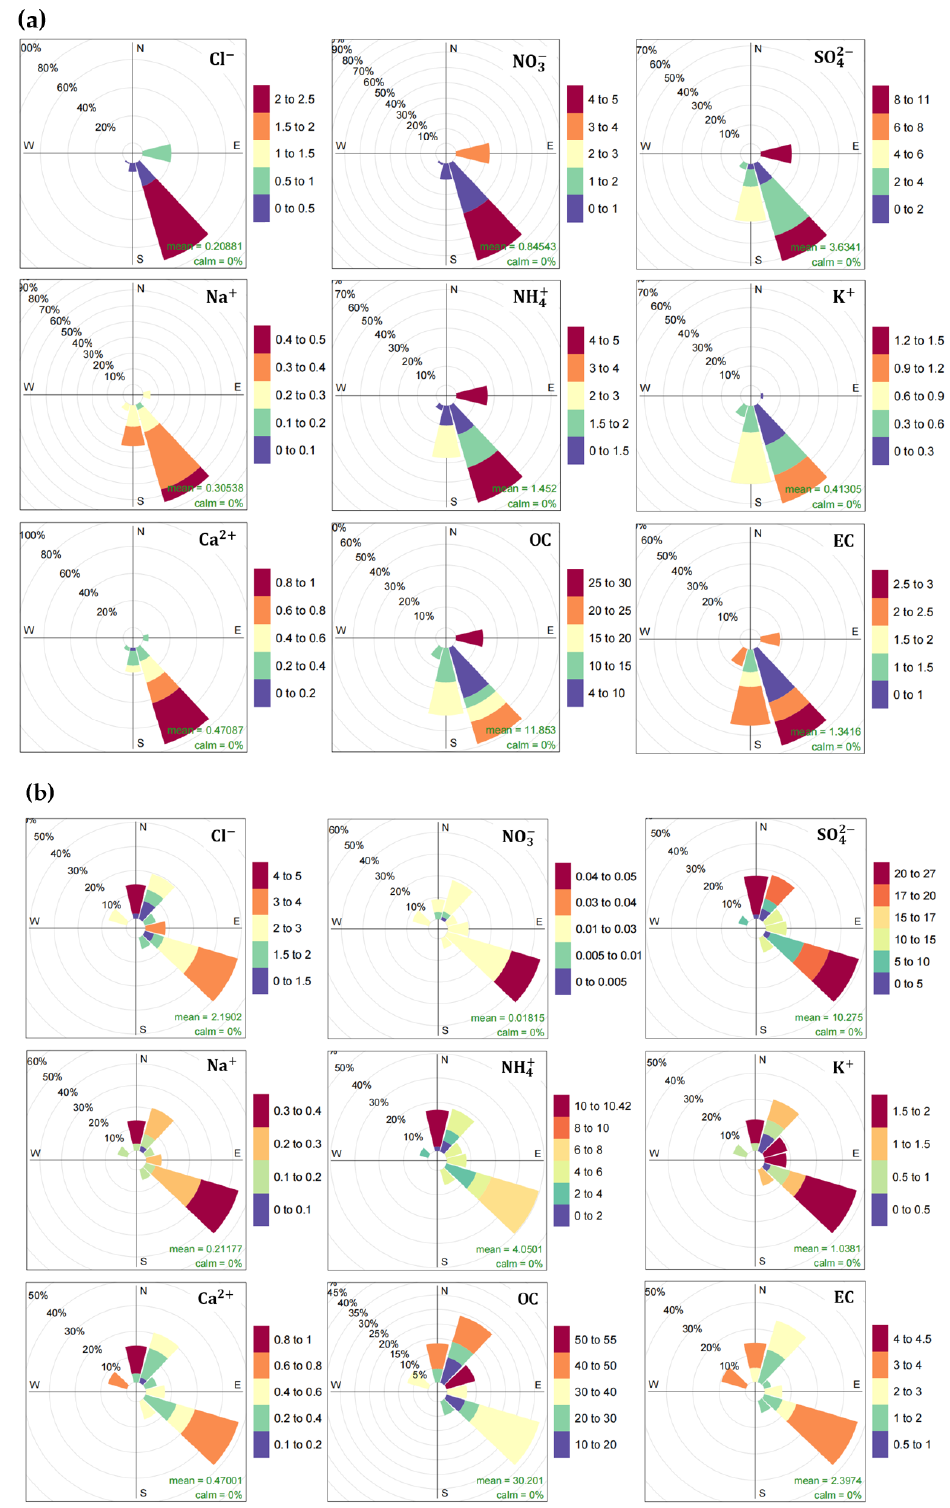
Figure 6. Spatial pattern of concentration of key chemical compositions in PM 2.5 in relation to wind direction during: ( a ) summer period; ( b ) winter period (for interpretation of the references to color in this figure legend, the reader is referred to the web version of this